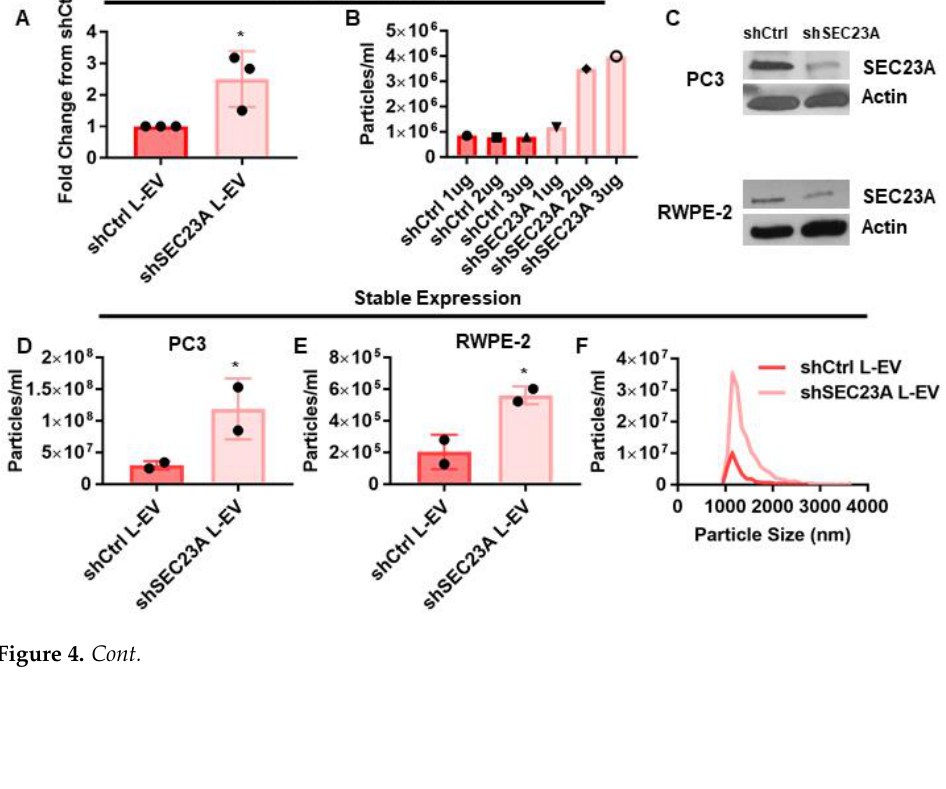
Figure 4. Inhibition of SEC23A induces L-EV shedding. ( A ) Quantification of L-EV shedding by TRPS in PC3 cells transiently transfected with SEC23A shRNA ( n = 3). ( B ) Quantification of L-EV shedding by TRPS after transient transfection with increasing doses of SEC23A shRNA ( n = 1). ( C ) Expression of SEC23A in PC3 cells stably expressing SEC23A shRNA. ( D – I ) Quantification of L-EV ( D , E ) and S-EV ( G , H ) shedding by TRPS in PC3 ( D , G ) and RWPE-2 ( E , H ) cells stably expressing SEC23A shRNA ( n = 2). ( H , I ) Size distribution of L-EV ( F ) and S-EV (I) from PC3 cells stably ex- pressing SEC23A shRNA. ( J ) Western blot for EV markers from EV isolated from PC3 cells stably expressing SEC23A shRNA; * p < 0.05. 4. Discussion A few reports suggest a functional role for miR-1227 in cancer (in glioblastoma, in particular) [2]. In prostate cancer, miR-1227 has been identified as a non-coding RNA that is enriched in EVs from tumorigenic cells but not in EVs from an isogenic, non-tumor- igenic cell line. Here, we show that miR-1227 is present at discrete levels in biological